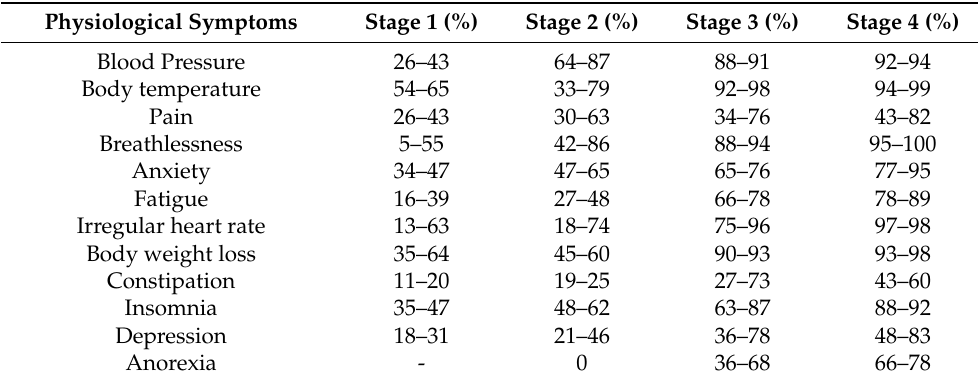
Table 1. Symptoms manifest at various stages of lung cancer